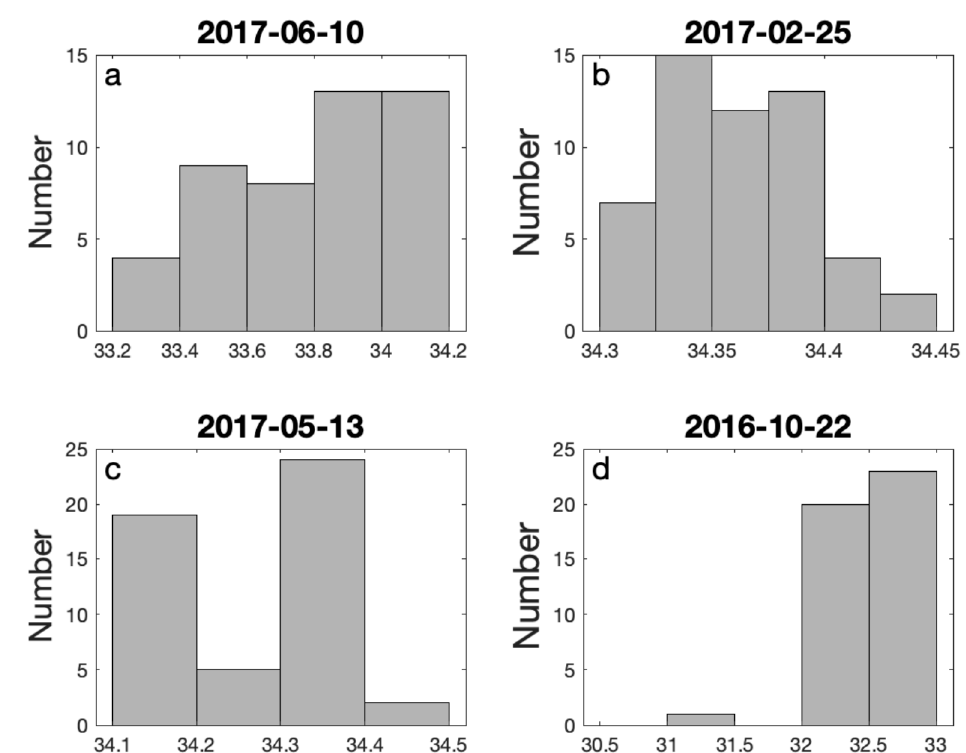
Figure 10. Examples of distributions of SSS from SPURS-2 waveglider data. y -axes are the number of observations. Distributions are for the 7-day period surrounding the dates shown at the top of each panel, ( a ) 10-June-2017, ( b ) 25-Feb-2017, ( c ) 13-May-2017 and ( d ) 22-Oct-2017. Note inconsistent axis scales.